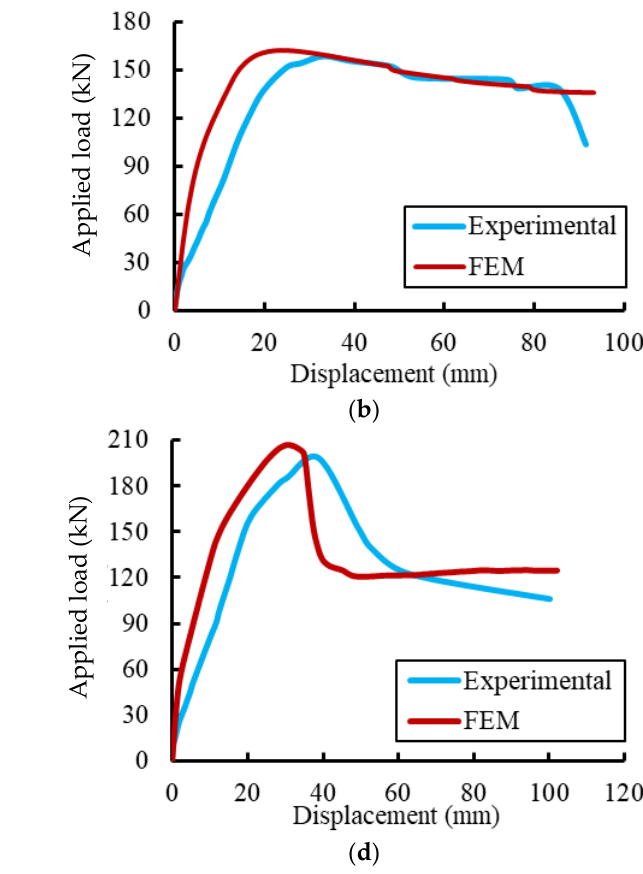
Table 7. Fracture energy of pultruded GFRP I- section beam.